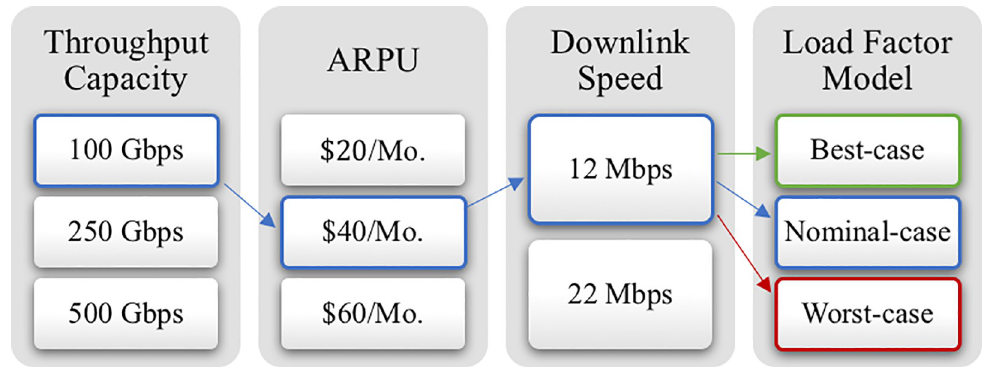
Fig 8. Discrete choices for some key HTS parameters. 54 different combinations were generated and value-analyzed. Results for the three highlighted scenario combinations are here presented.